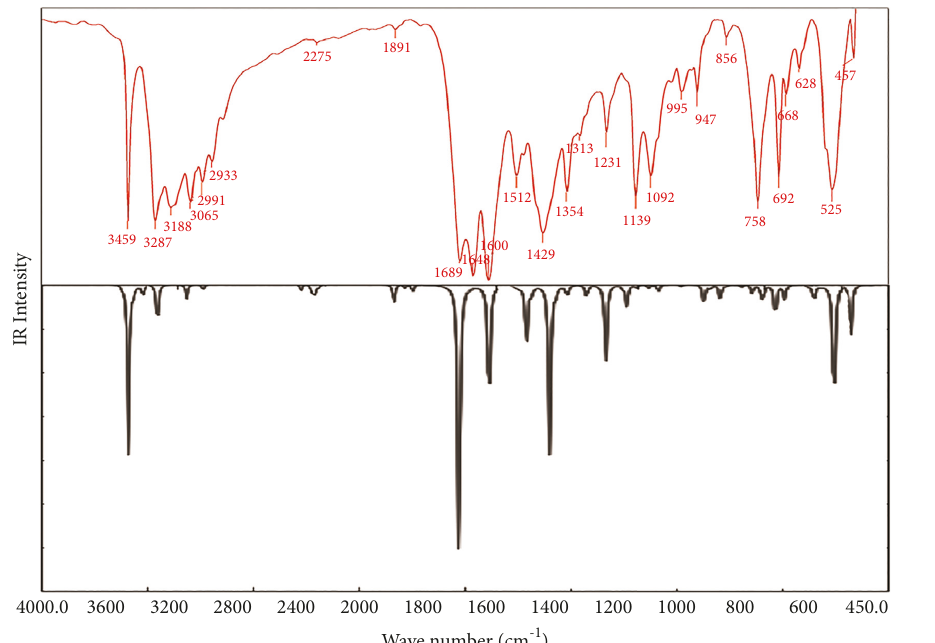
Figure 8: Experimental (a) and calculated (b) FT-IR spectra of BDSC.